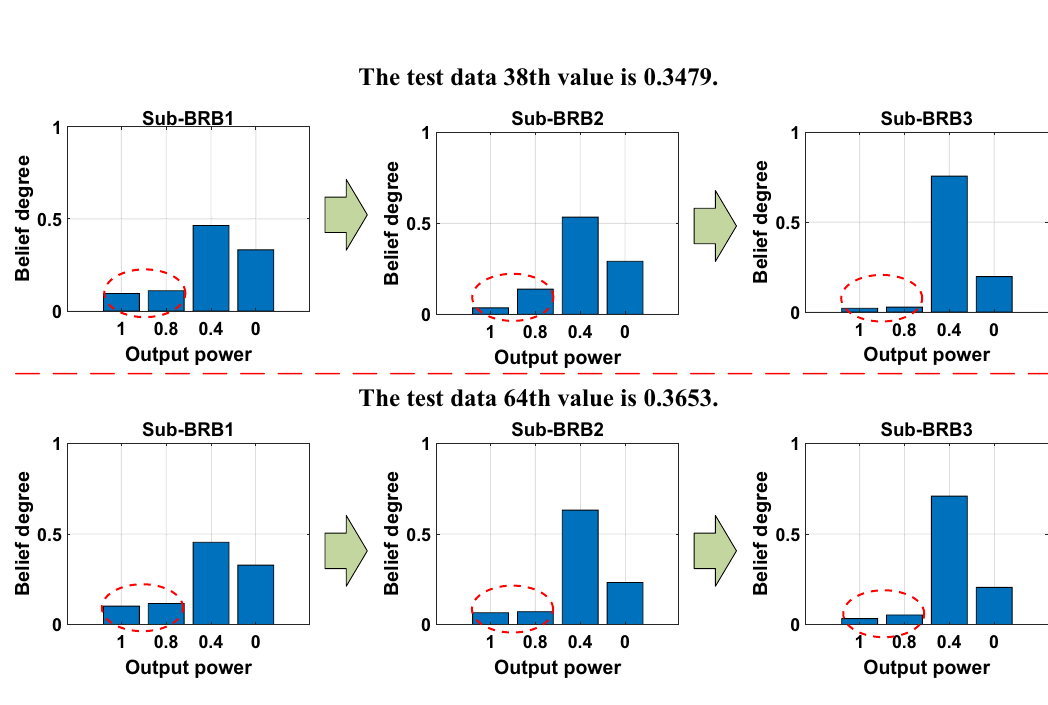
Figure 18. Transparency and validity of the DBRB-I(20)